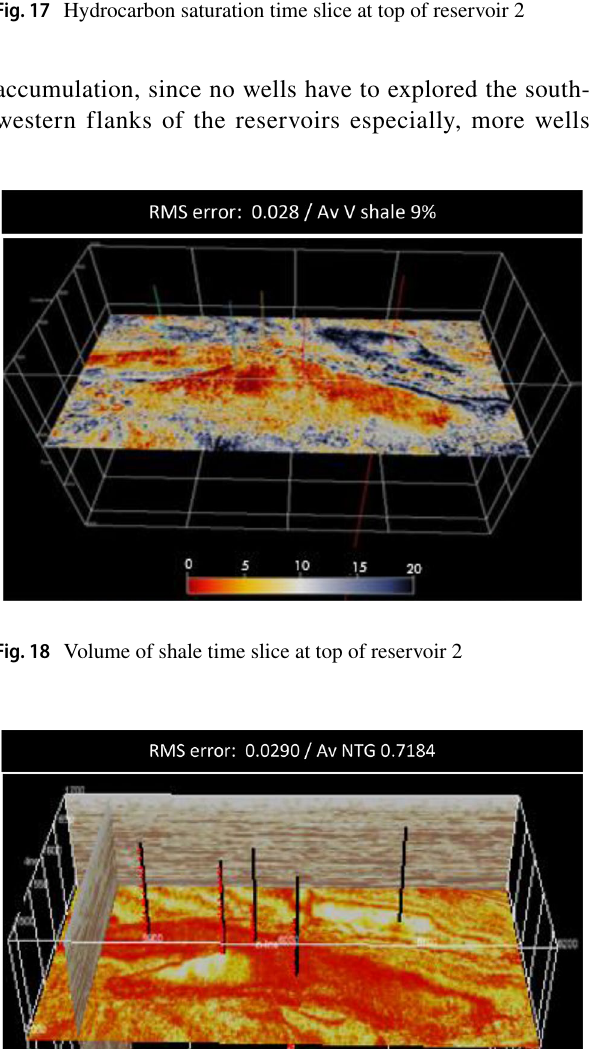
Fig. 17 Hydrocarbon saturation time slice at top of reservoir 2